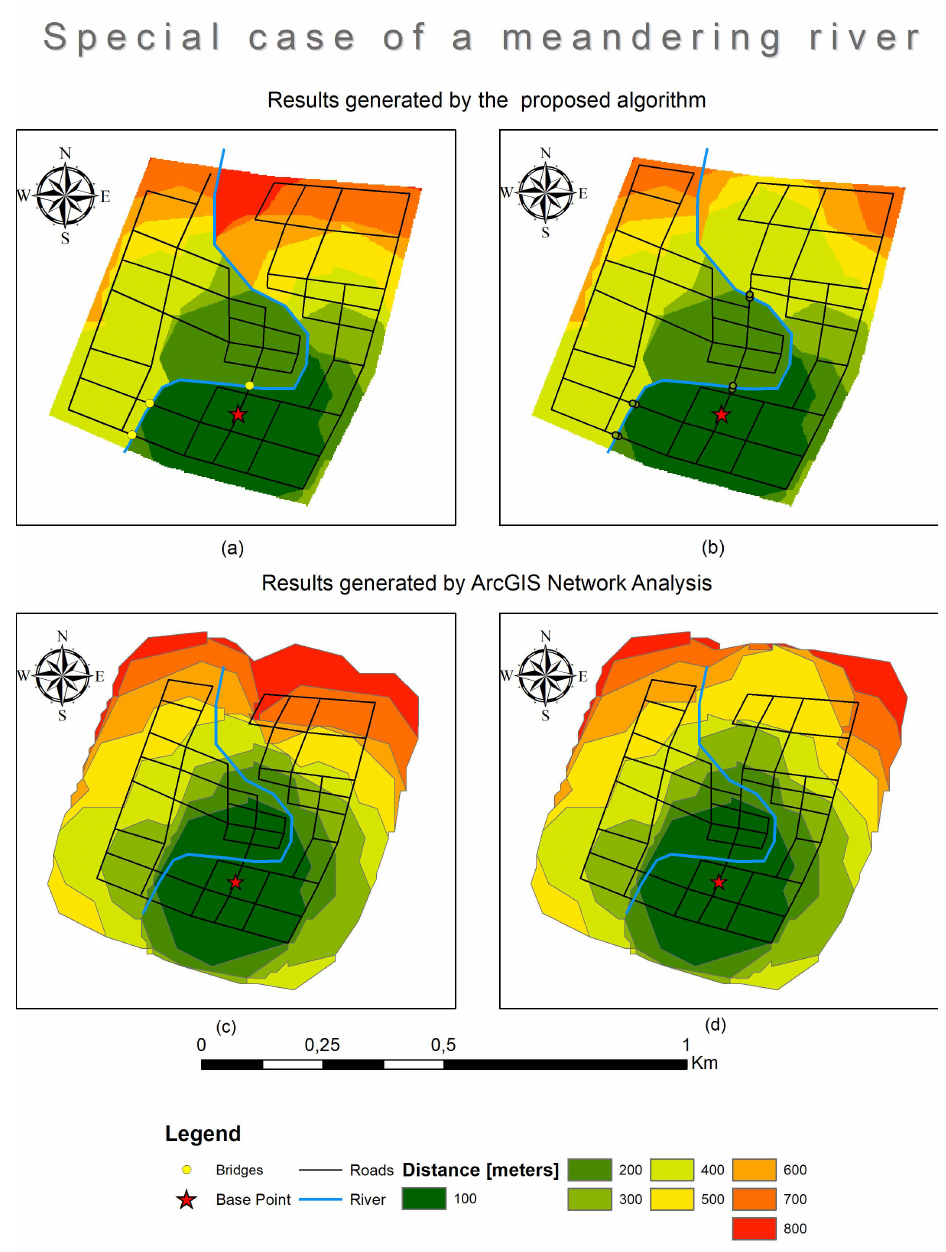
Figure 20. Special case of a linear barrier—a meandering river. The analyzed area was not limited to sub-areas: ( a ) results generated by the algorithm for three bridges; ( b ) results generated by the algorithm for four bridges; ( c ) results generated by ArcGIS network analysis without possible flow to base area; ( d ) results generated by ArcGIS network analysis with possible flow to base